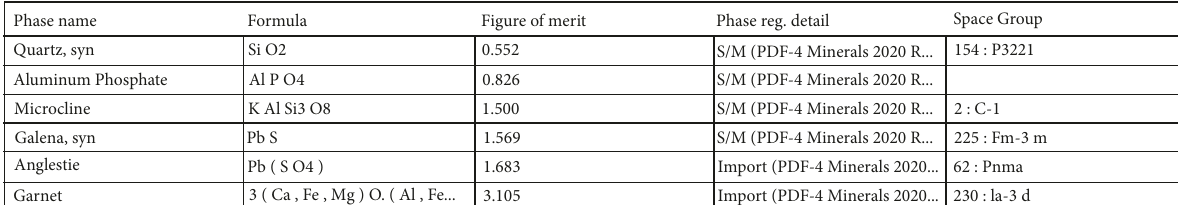
Figure 7: XRD of the crude oil contaminated soil